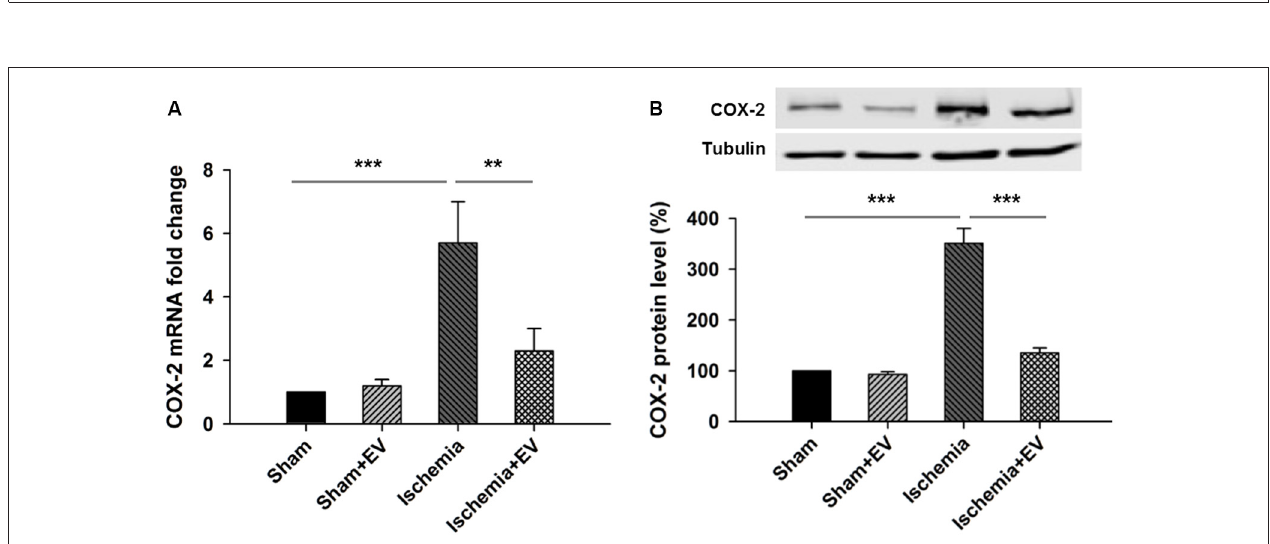
FIGURE 2 | Effects of BMSC-EVs on 5 min of bilateral common carotid artery occlusion-induced COX-2 expression at mRNA and protein levels in the hippocampi. Intracerebroventricular injection (ICVI) of 200 µ g BMSC-EVs right before occlusion largely suppressed pathogenic expression of COX-2 at (A) mRNA level (sham + EV = 96 ± 4, ischemia = 5.7 ± 1.5, ischemia + EV = 2.2 ± 0.7) and (B) protein level (sham + EV = 1.2 ± 0.15, ischemia = 341 ± 39, ischemia + EV = 128 ± 10). n = 8 tests per group. Data show means ± SEM. One-way ANOVA analysis followed by a Tukey’s post hoc test. ∗∗ p < 0.01 and ∗∗∗ p <